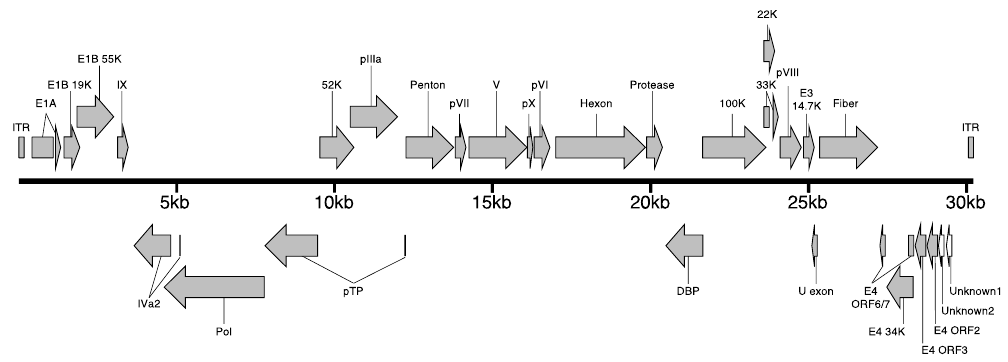
Figure 2. Genome organization of EhAdV 06-106. The genome of EhAdV 06-106 is represented by a bold bar, with the scale indicated below. Viral genes and inverted terminal repeats (ITR) sequences are shown as arrows or rectangles, respectively. The gray-shaded arrows represent open reading frames (ORFs) homologous to reported bat adenoviruses; open arrows represent unknown ORFs. Coding regions linked with a line indicate the predicted spliced transcript.